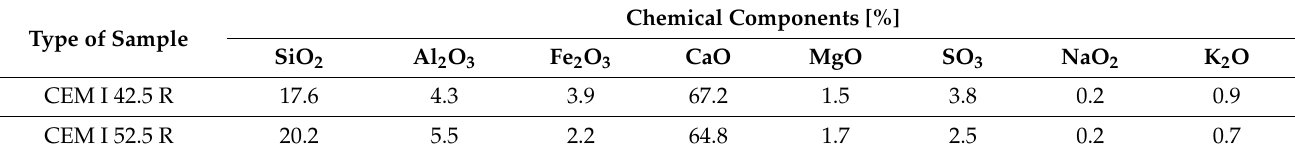
Table 2. Chemical composition of cement.